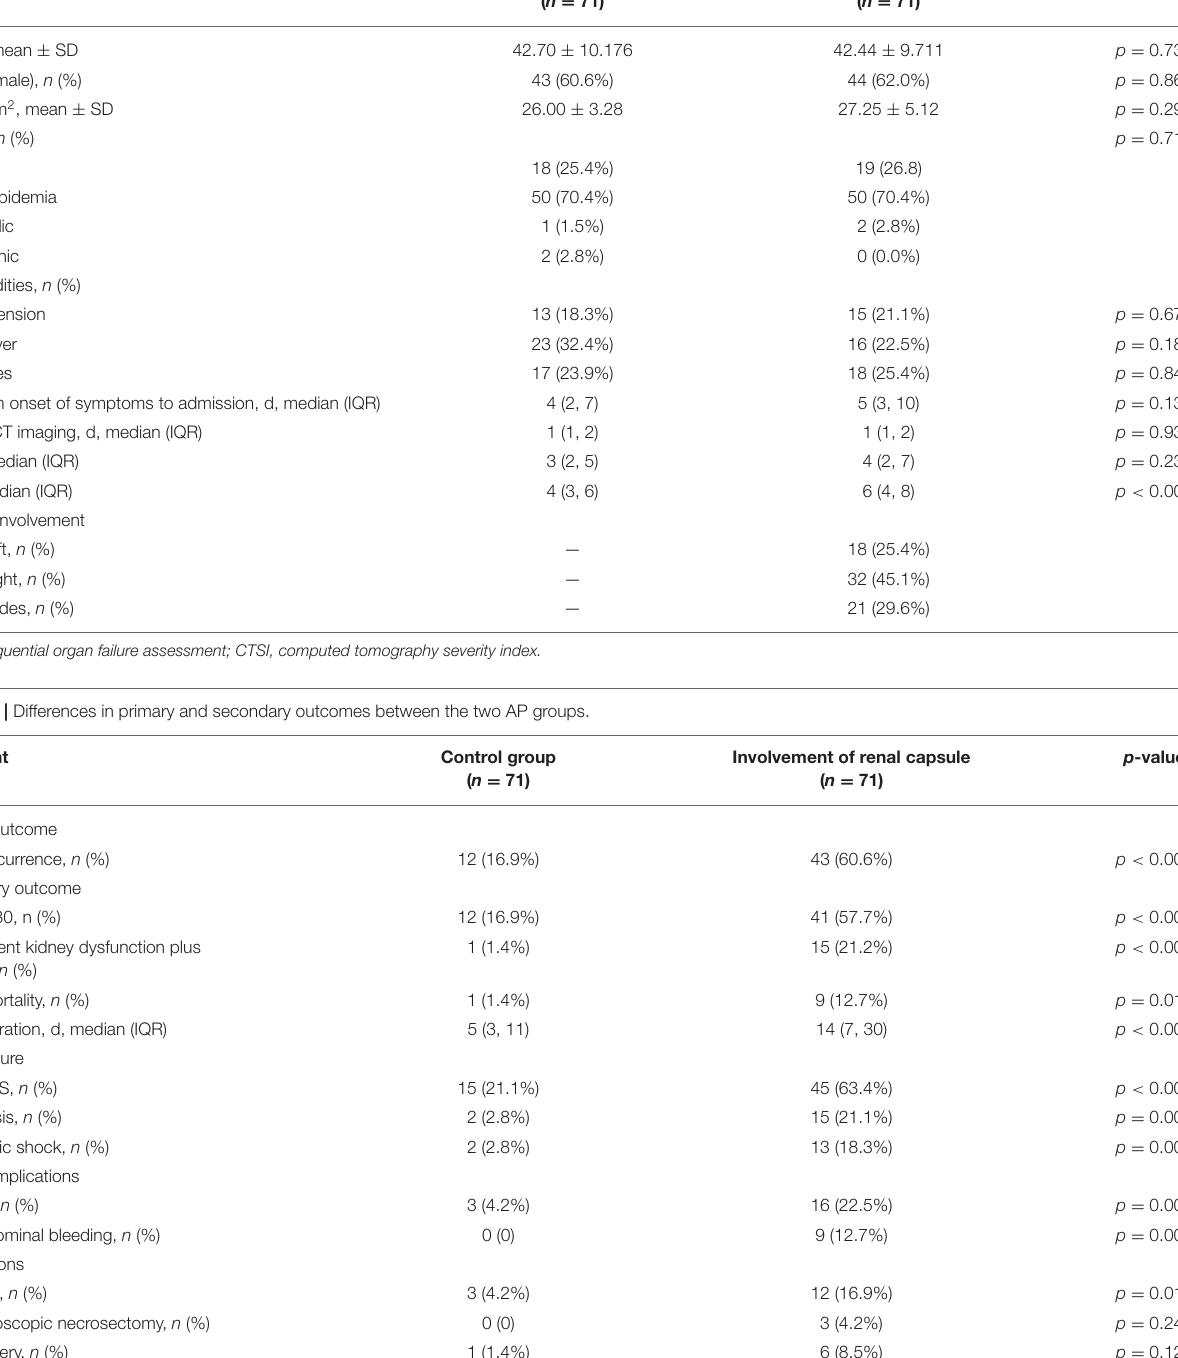
TABLE 1 | Differences in demographic and baseline clinical characteristics between the two AP groups. Variable